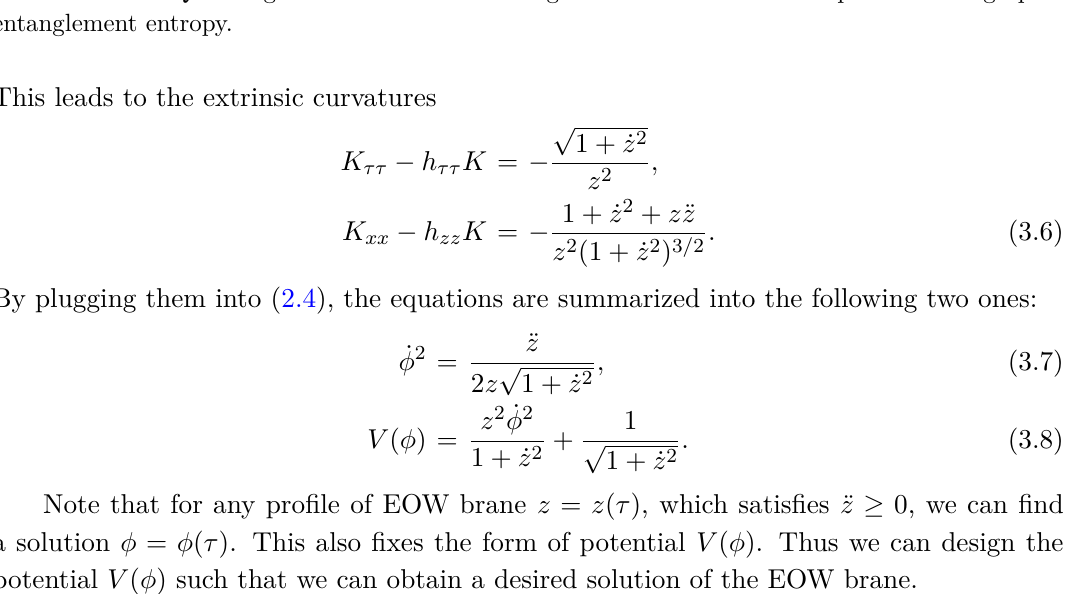
Figure 2 . The setup of AdS 3 / BCFT 2 with a planar EOW brane. The red curve shows the end-of- the-world-brane Q . The green curves describe the geodesics Γ (1 , 2) which compute the holographic entanglement